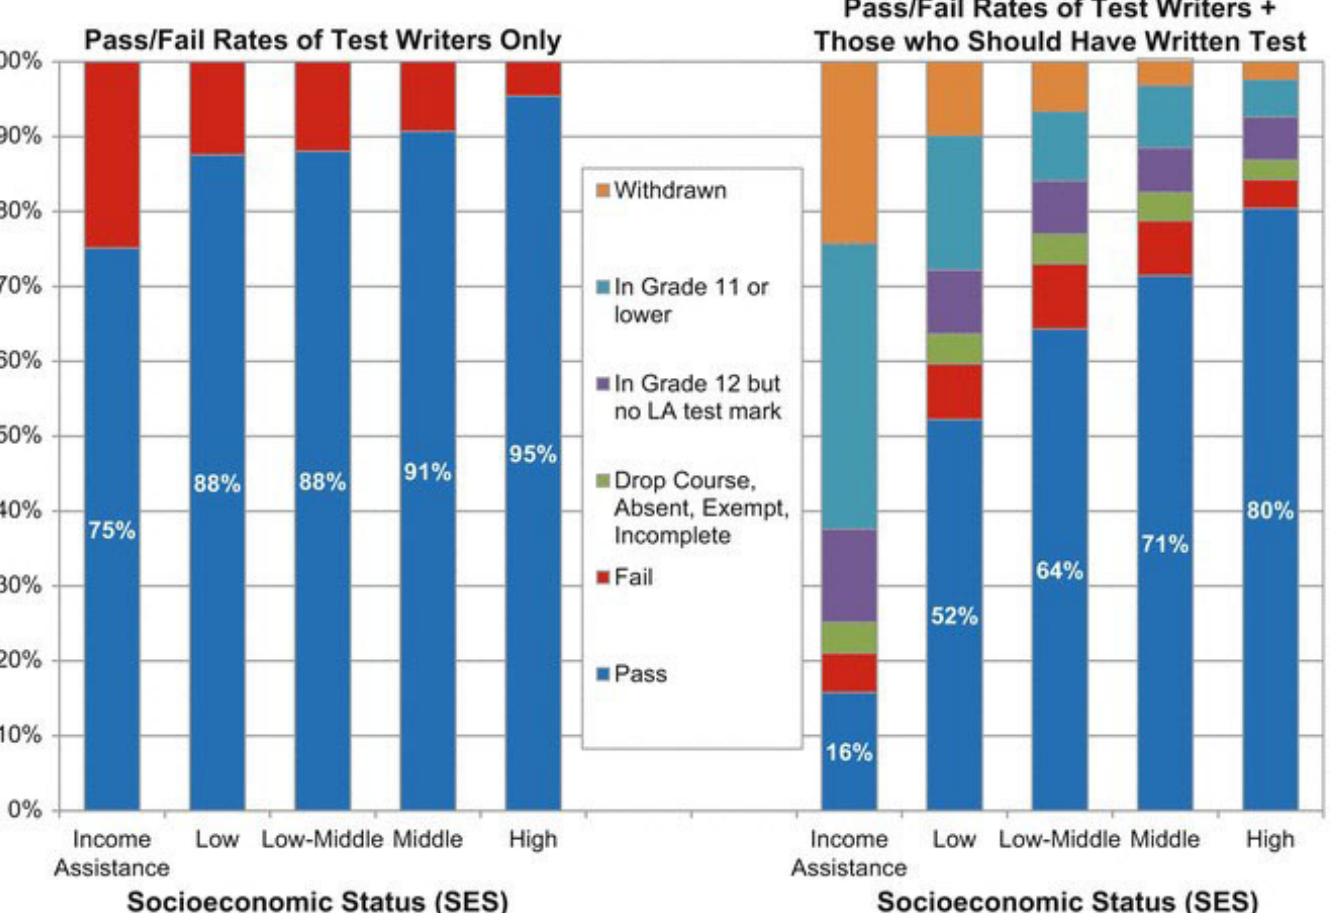
Figure 1: Performance of Grade 12 Students in Manitoba by Socioeconomic